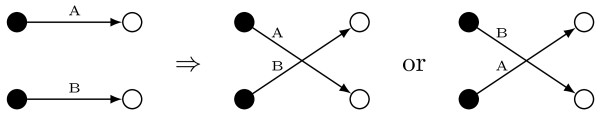
Diagram representing the rewiring method used by the randomization algorithm. Two random edges are chosen and either the sources or the targets are switched with equal probability.